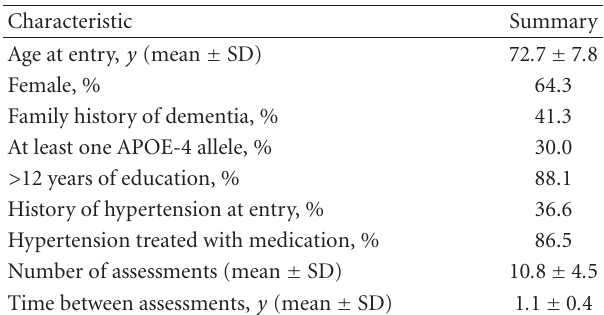
Table 2: Subject characteristics ( n =